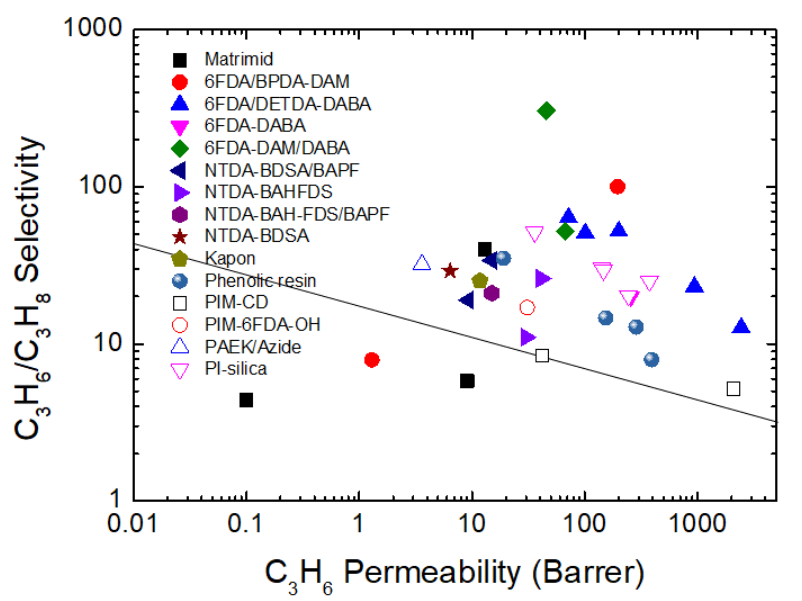
Figure 20. Upper-bound trade-off for CMS membranes derived from a variety of polymer precur- sors.